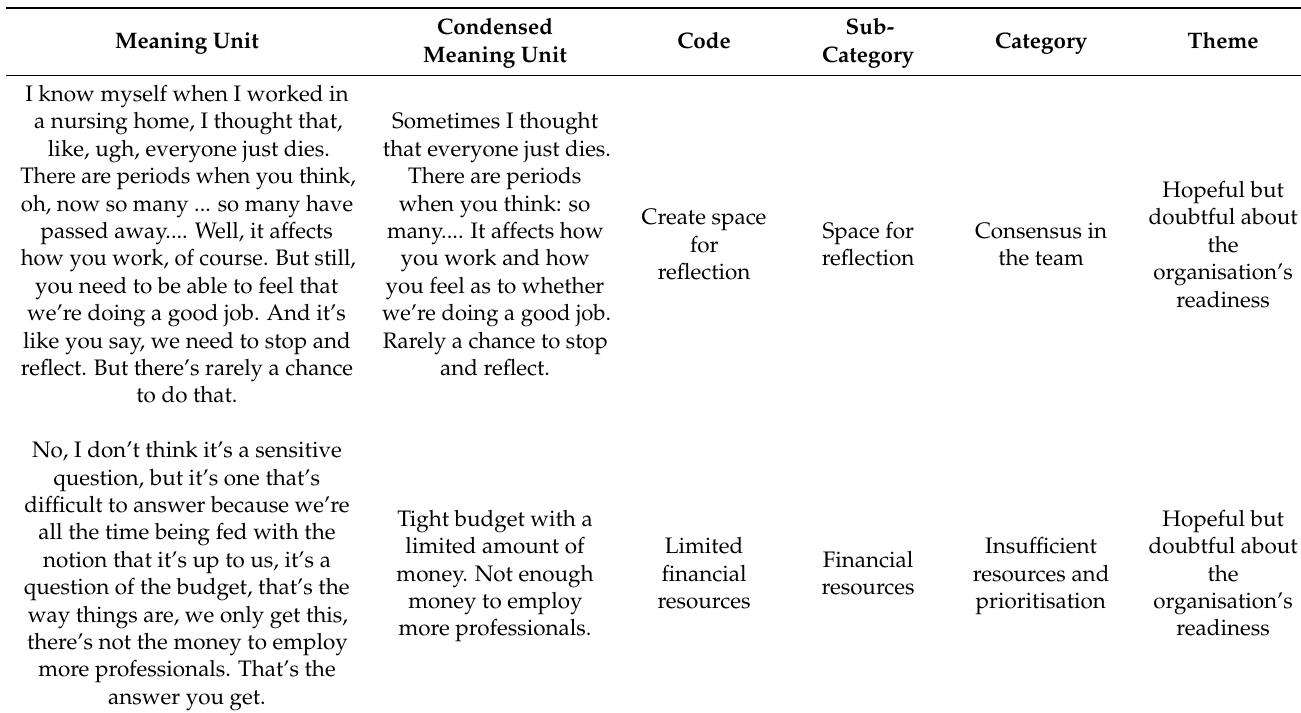
Table 1. Examples of the analytical